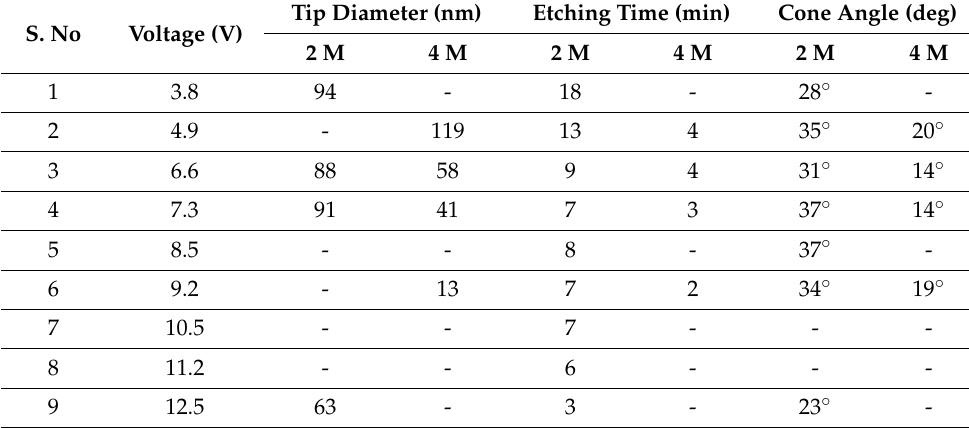
Table 1. Experimental results for 0.4 mm tips showing tip diameter, etching time and Cone Angle produced in 2 M and 4 M NaOH solution on AC